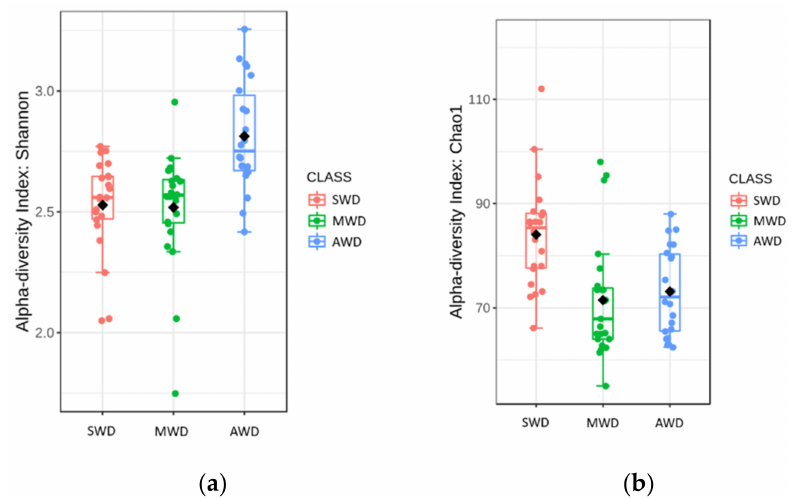
Figure 4. Boxplot illustrating the differences in ( a ) Chao1 and ( b ) Shannon diversity measures at both sam-pling times of the fungal communities in the rhizosphere at different irrigation regimes: